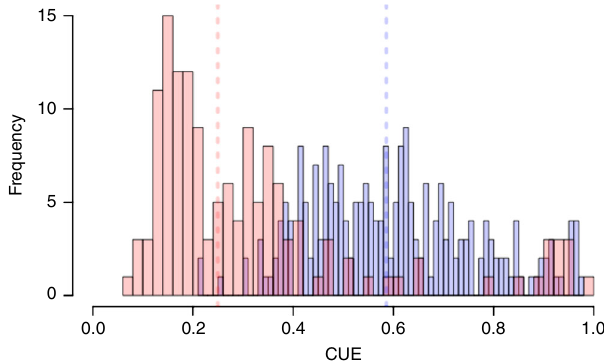
0.00.20.40.60.81.0 Fig. 2 Substrate-limited CUE. Boxplot of average CUE values across all taxa under potential and constrained scenarios. Boxplot width is proportional to number of models with a given constraining reaction. Dashed red line shows average for potential CUE. Shaded region shows range of values typically used in biogeochemical models. Solid lines within boxplots show median. Bottom and top edges of boxes represent 25th and 75th percentiles, respectively. Whiskers demarcate minimum and maximum datapoints within 1.5× of the interquartile